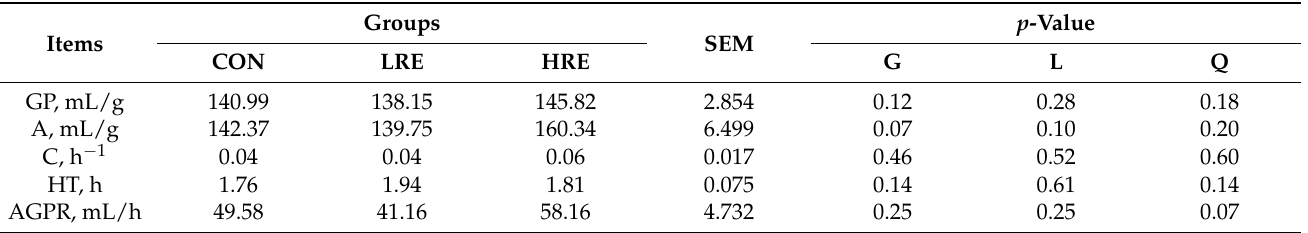
Table 1. Effects of different doses of rosemary extract on gas production parameters of in vitro fermentation.